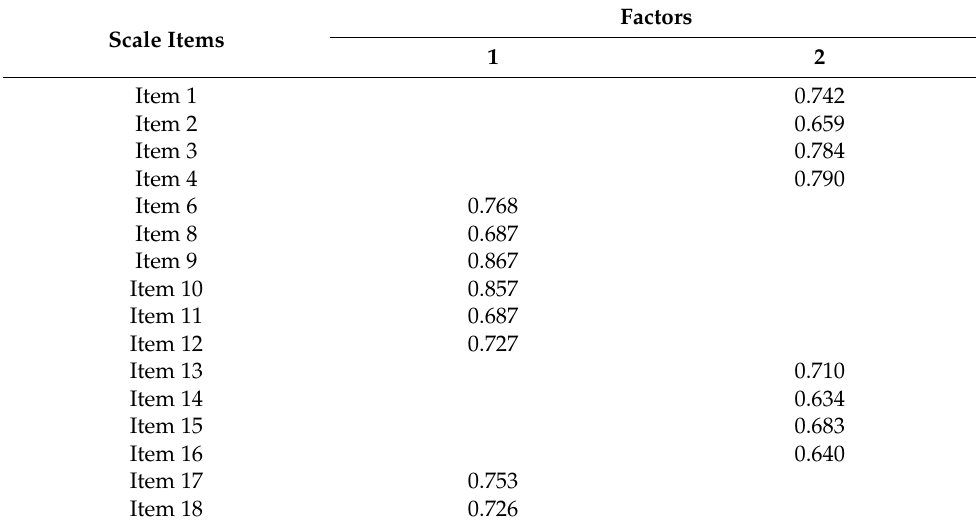
Table 3. Exploratory factor analysis: rotated factor